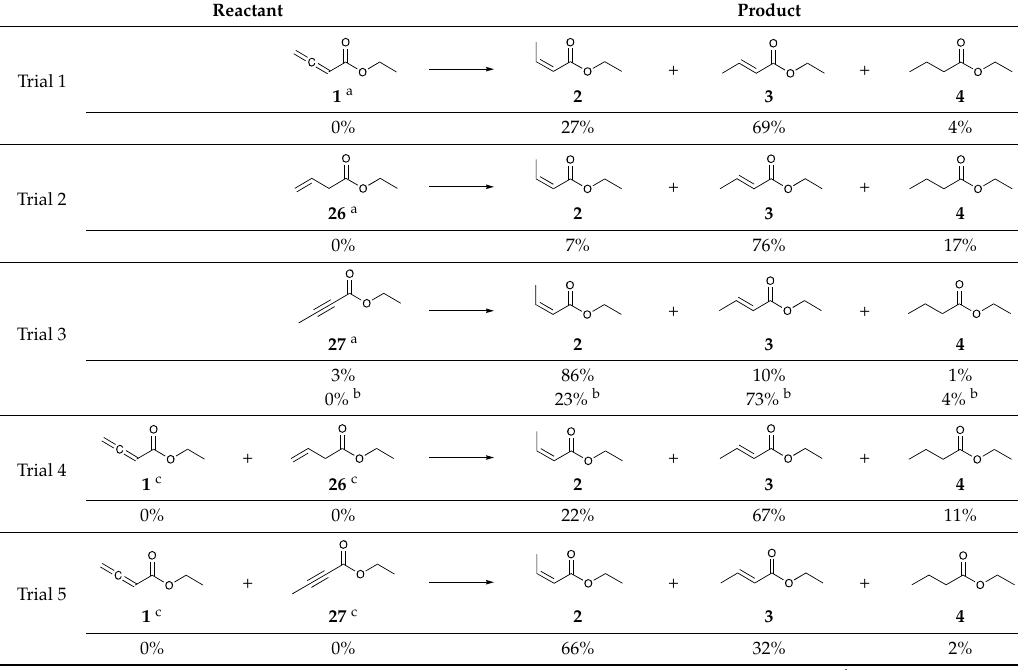
Table 4. The single-substrate and dual-substrates catalytic reaction of various unsaturated esters.